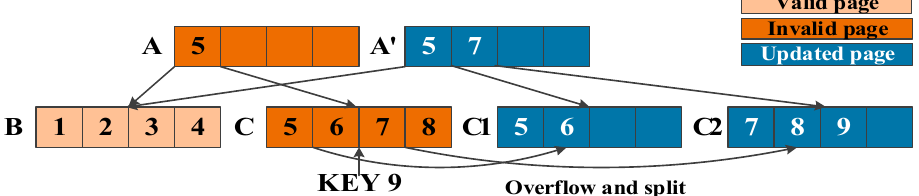
Figure 8. Sequential insertions of the B-Tree.